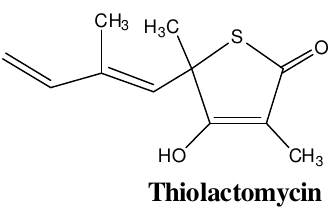
FIGURE 14. Structure of thiolactomycin